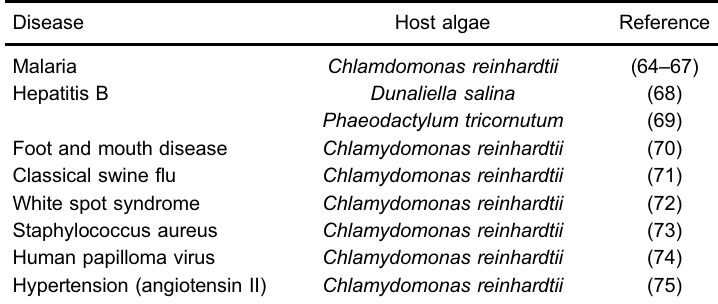
Table 3. Edible algal vaccines for various